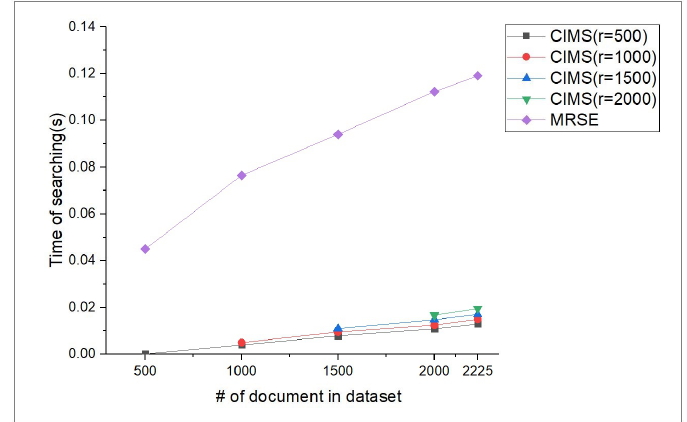
Figure 4. Comparison of search